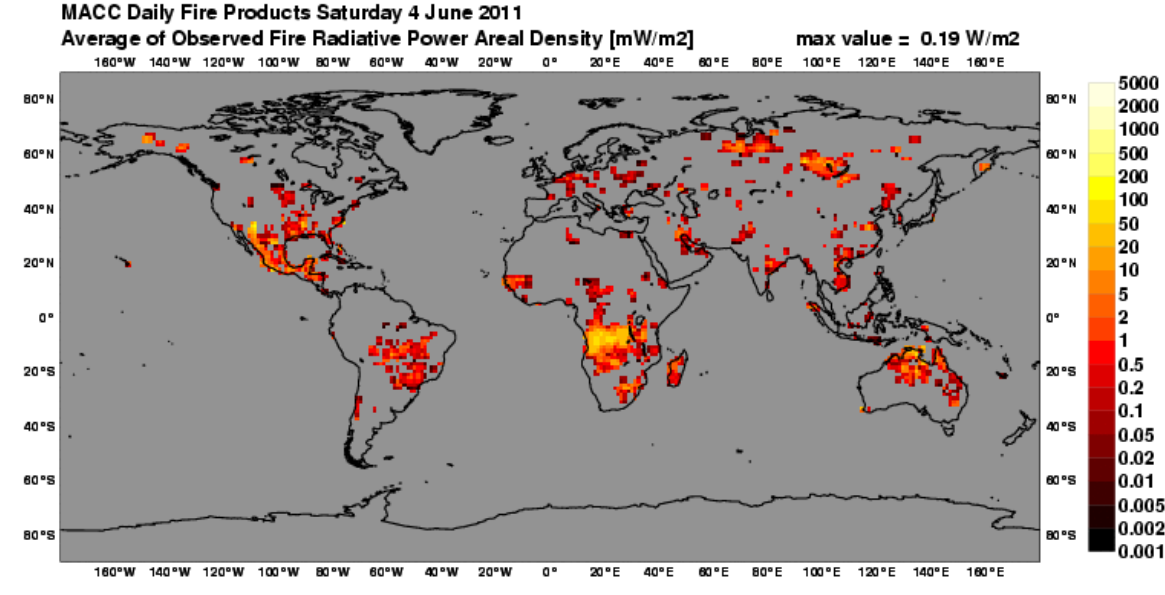
Fig. 1. Daily average Fire Radiative Power (FRP) density [mWm − 2 ] analysis of GFASv1.0 for 4 June 2011, based on observations from the two MODIS instruments. Equidistant cylindrical projection, 0.5 ◦ resolution. Published at http://gmes-atmosphere.eu/fire on 5 June 2011.